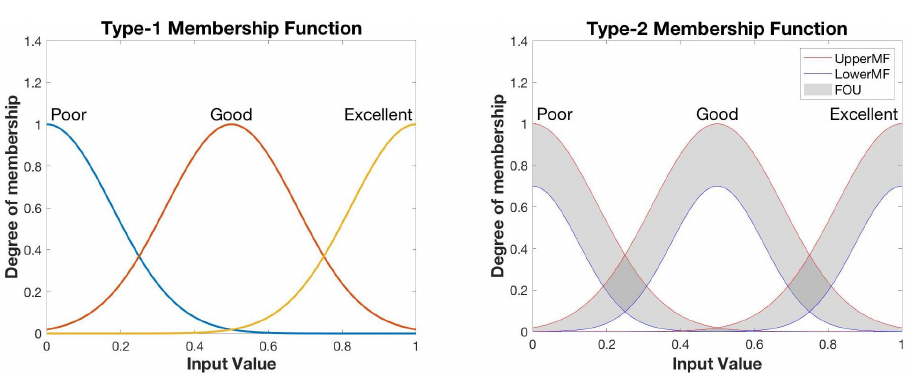
Figure 5. Example membership functions for T1 ( left ) and T2 ( right ) Fuzzy